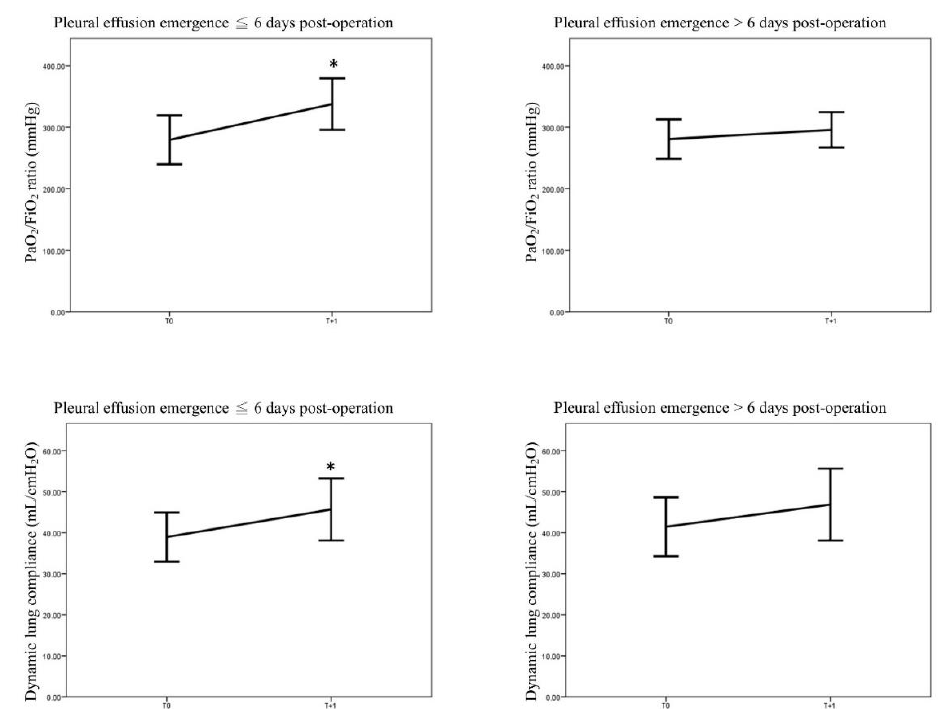
Figure 3. Changes in the PaO 2 /FiO 2 ratio and lung compliance in patients stratified according to the time interval from the onset of pleural effusion to pleural effusion drainage ( ≤ 6 days versus >6 days); * p value < 0.05.